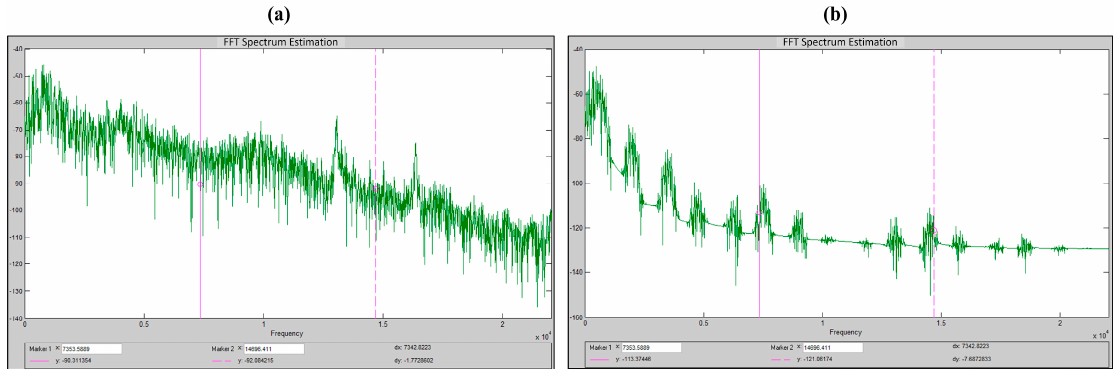
Figure 12. ( a ) Frequency components of the original signal; and ( b ) frequency components of the denoised signal.